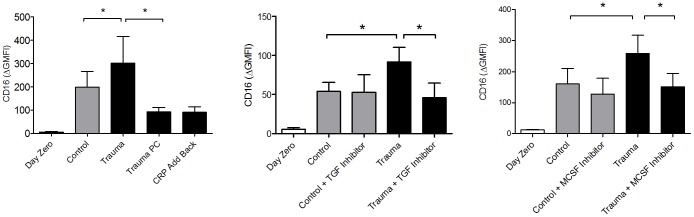
Surface CD16 expression on CD14+ monocytes before and after incubation with control or trauma patient plasma for 22 hours was decreased with CRP depletion (Trauma PC), but was not restored with CRP add-back experiments.TGF-β receptor inhibition with SB431542 (TGF Inhibitor) and M-CSF receptor inhibition with Ki20227 (M-CSF Inhibitor) significantly reduced CD16 expression of normal monocytes. * P<0.05; nonparametric Wilcoxon test was used to determine statistical significance; n = 6 for each separate experiment.